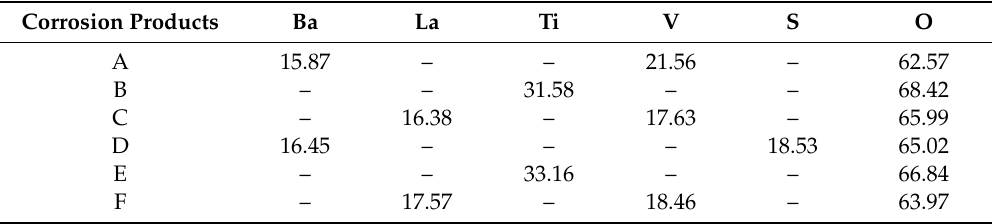
Figure 2. Surface morphologies of the as-fabricated BaLa 2 Ti 3 O 10 pellet ( a ), and the samples after V 2 O 5 corrosion ( b , c ) and Na 2 SO 4 + V 2 O 5 corrosion ( d – f ). Table 1. Compositions of compounds A–F in Figure 2 (in at.%).